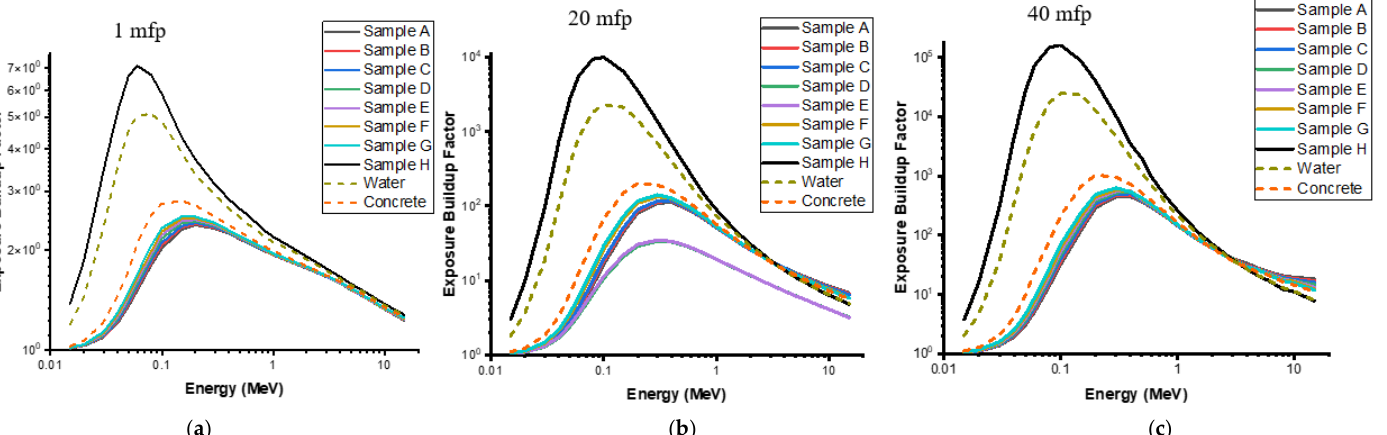
Figure 5. EBF of the Samples compared with water and concrete for energy region 0.015–15 MeV at 1, 20 and 40 mfp, respectively. ( a ) is 1 mfp, ( b ) is 20 mfp and ( c ) is 40 mfp.